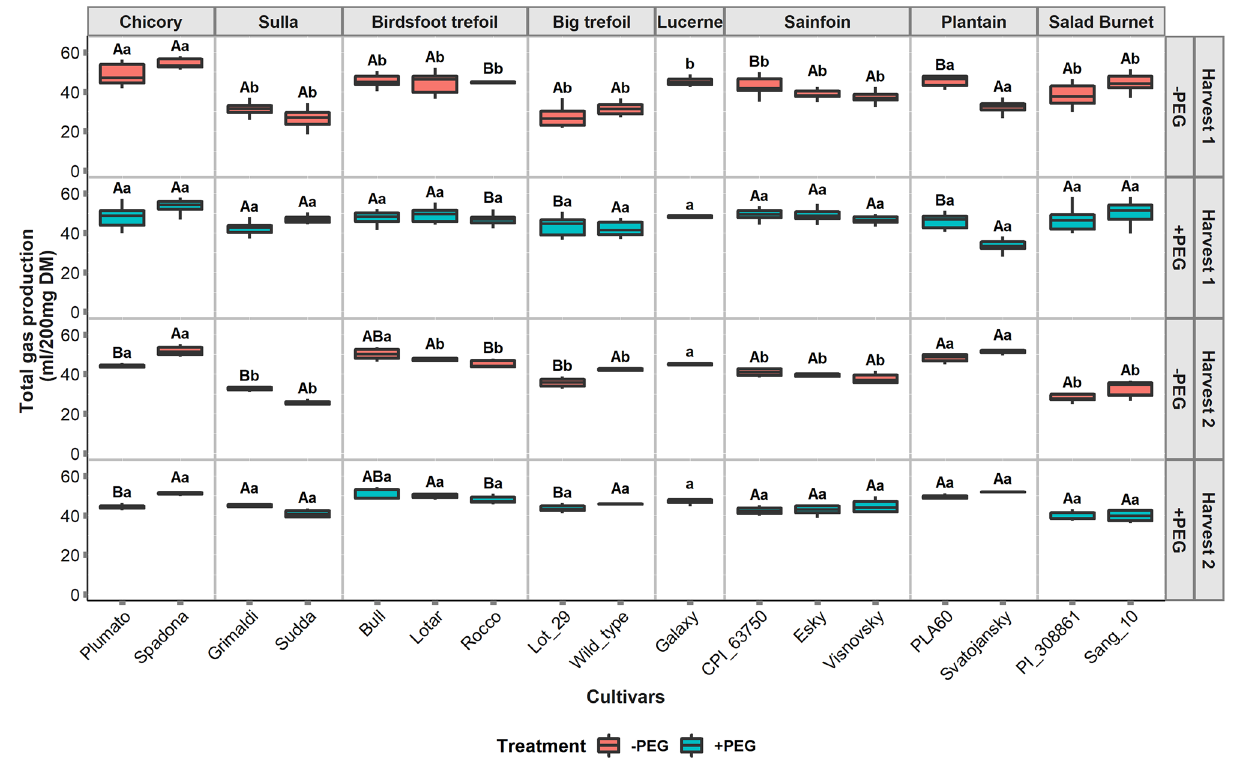
Figure 2. Gas production from 17 cultivars of 8 species under different treatments for two harvests. −PEG indicates the samples incubated without polyethylene glycol (PEG) and + PEG refers to the samples incubated with PEG. Different uppercase letters represent significant differences ( P < 0.05) between the cultivars for each species, and different lowercase letters represent the significant differences within the treatments for each